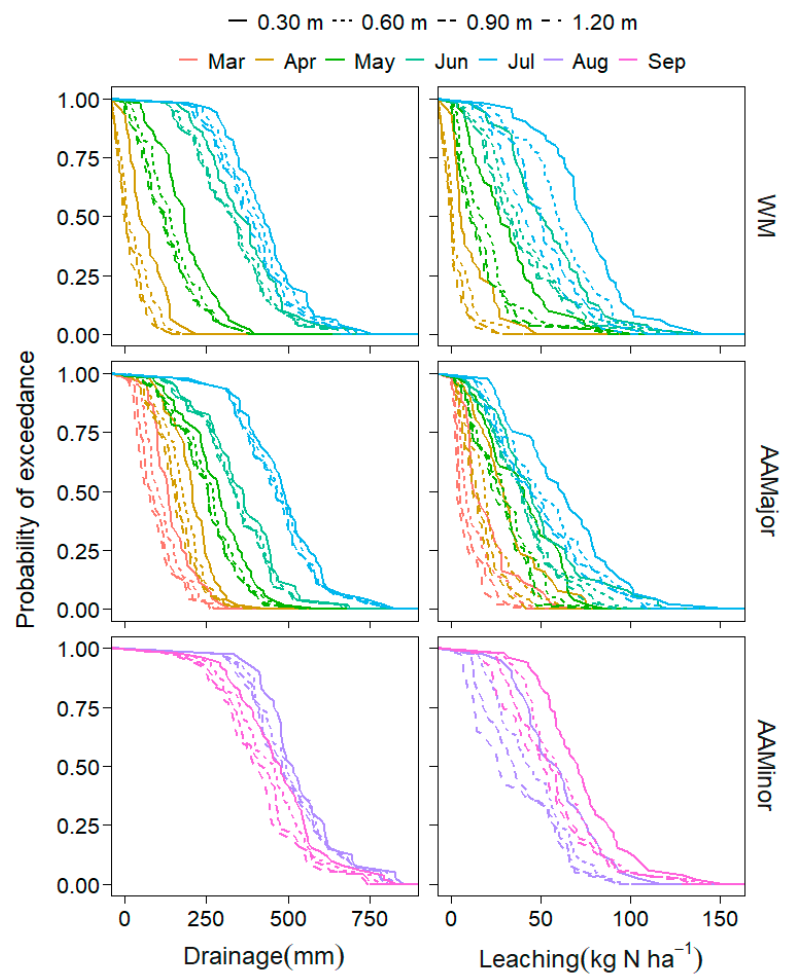
Figure 10. Simulated NO 3 -N leaching and drainage against the grain yield for 75 kg N ha − 1 rate, sowing window and constricted rooting depth.